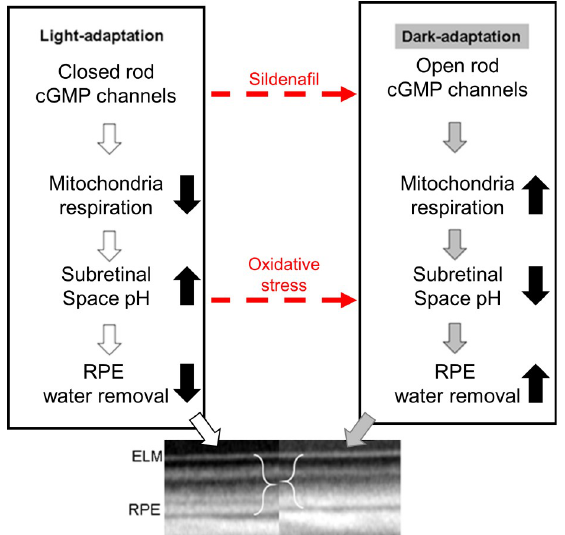
Fig 10. Working model of factors that regulate the ELM-RPE thickness. Oxidative stress is hypothesized to induce an acidosis (dotted red line) that would be expected to convert a thicker “light” ELM-RPE phenotype into a thinner “dark-like” phenotype (see text for details); this expectation is supported experimentally [24, 44, 63].